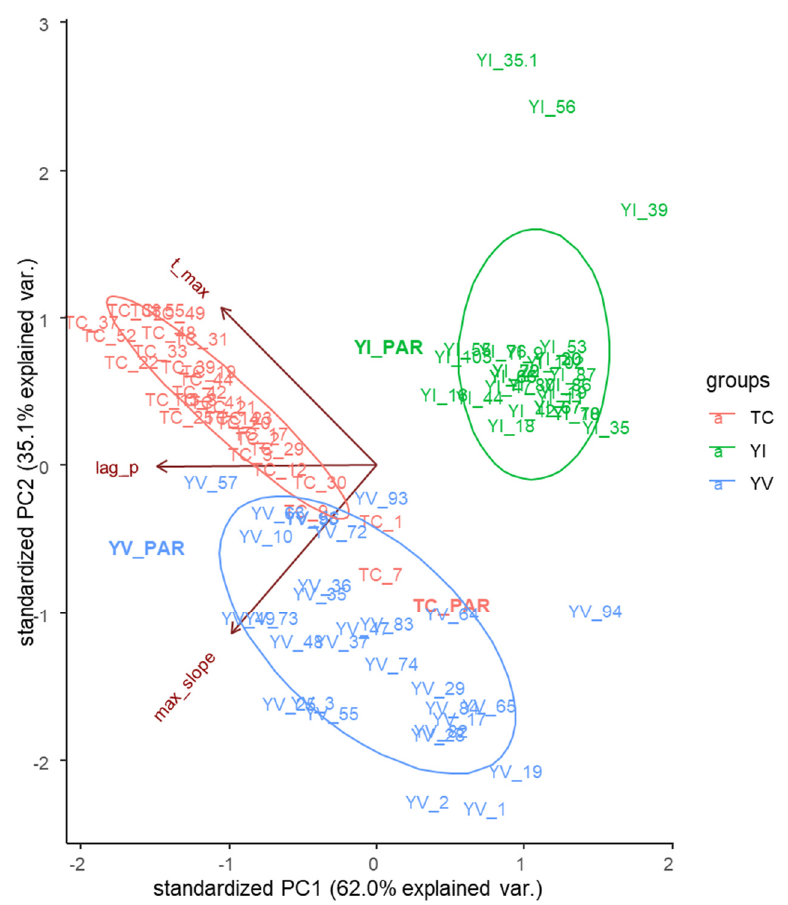
Figure 2. PCA biplot obtained from the growth parameters of all the 90 MSCs selected for the study. Input variables: Lag, t_max and max_slope growth parameters obtained using the pyphe-growthcurves tool from the growth curves of YVGC13A (YV, blue), TC1517 (TC, red), and YI30 (YI, green) cultures in SD with 2% glucose.